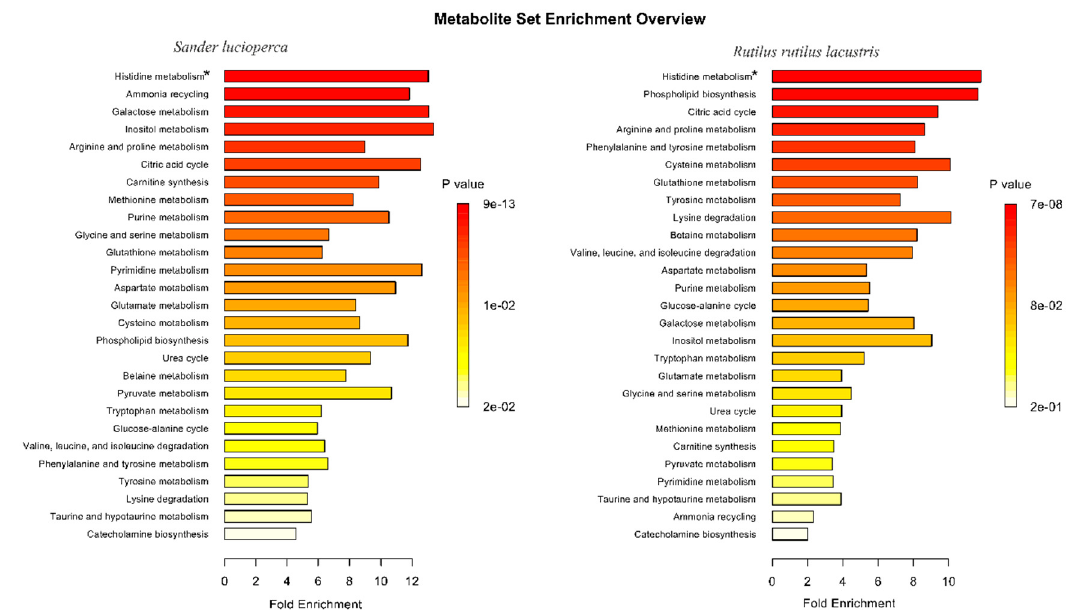
Figure 6. Metabolite set enrichment analysis based on the comparison of metabolite concentrations in lenses of autumn and winter S. lucioperca (left) and R. rutilus lacustris (right).